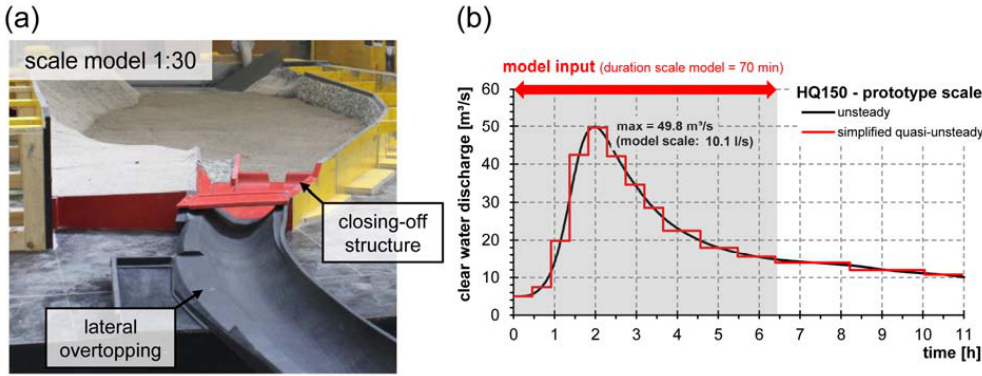
Fig. 2. (a) Overview of the scale model comprising the deposition basin, closing-off structure, bridge, paved channel and the overflow section situated on the orographic right-hand side of the channel; (b) unsteady HQ 150 -design flood (WLV, unpublished data) and simplified quasi-unsteady hydrograph representing the model input (prototype scale).